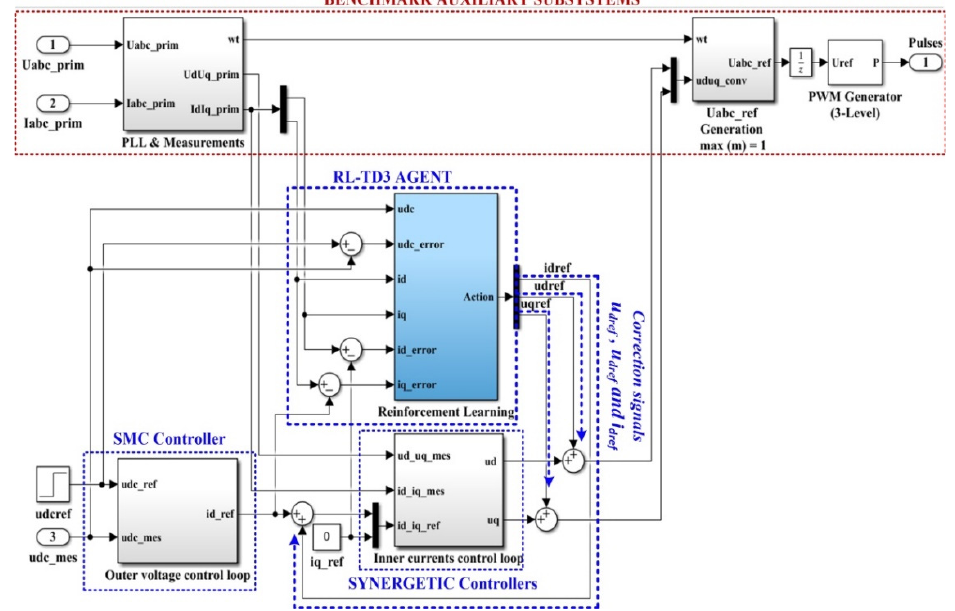
Figure 25. The MATLAB Simulink subsystem block implementation of the control system for the GC-PV array based on SMC and SYN and using the RL-TD3 agent for the correction of the u dref , u qref and i qref commands.